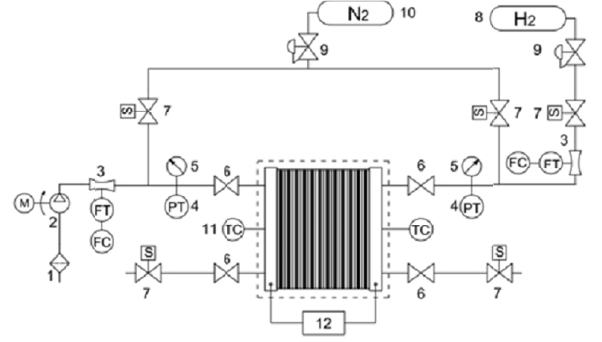
Figure 3: Sche uge, 6-valve, 7- he CompactR nfigured with